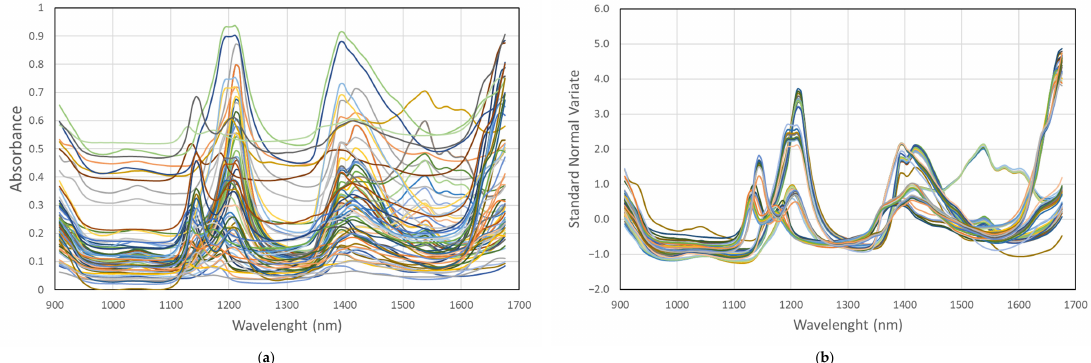
Figure 4. Raw spectra ( a ) and processed spectra, standard normal variate (SNV) ( b ) of 7 polymer types reference material (RM) with di ff erent particles size, distance to the instrument’s lamps and detector, taken by three di ff erent MicroNIR instruments and laptops merged in one